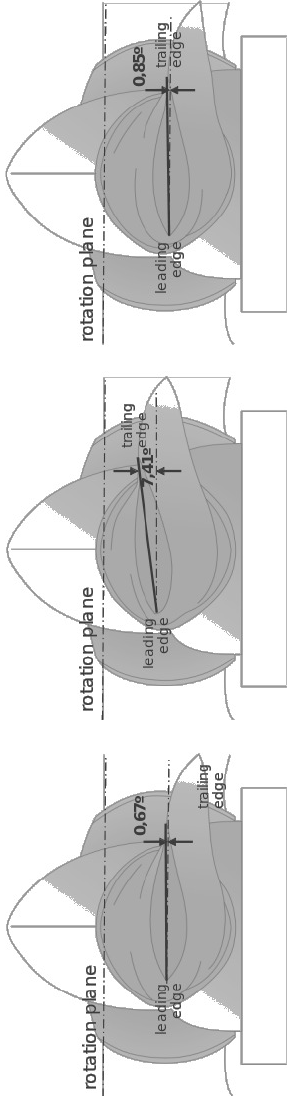
Figure 2. Photometry-based pitch angle measurement of a rotor blade